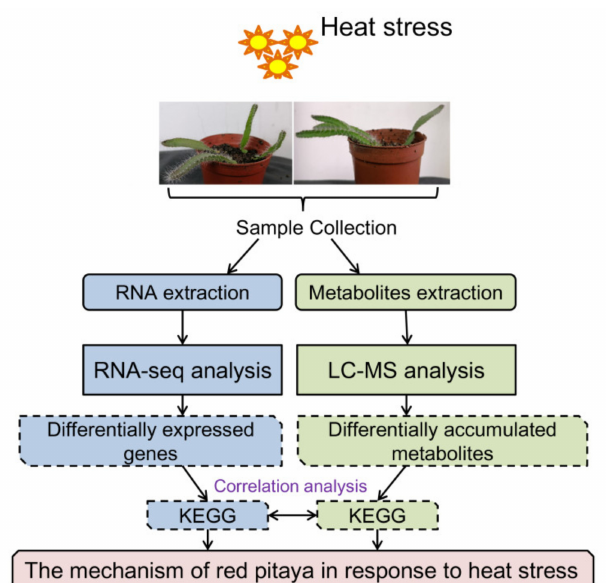
Figure 1. Flow chart of the experimental process. Blue represents the transcriptome process, and green represents the metabolome